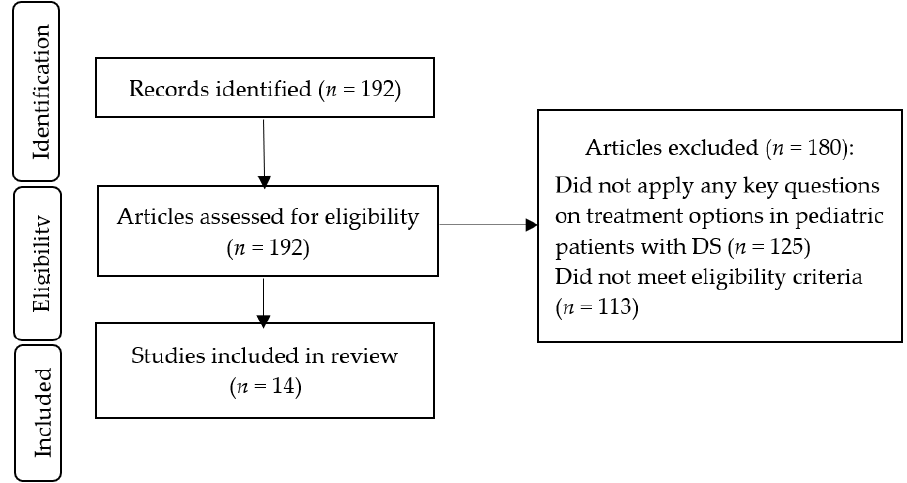
Figure 1. Flow chart of study selection. DS: Down